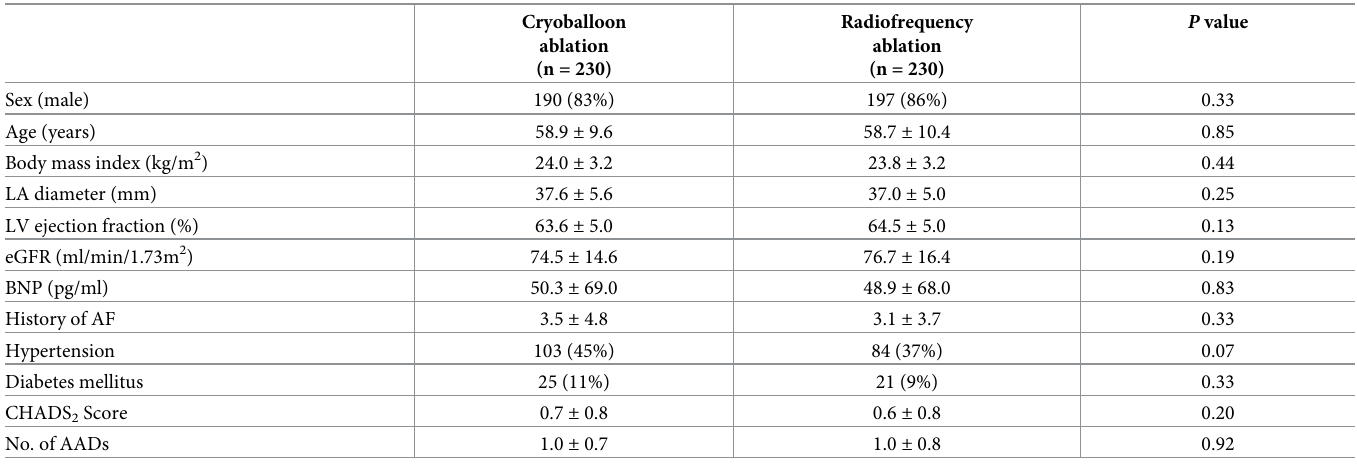
Table 1. Patient